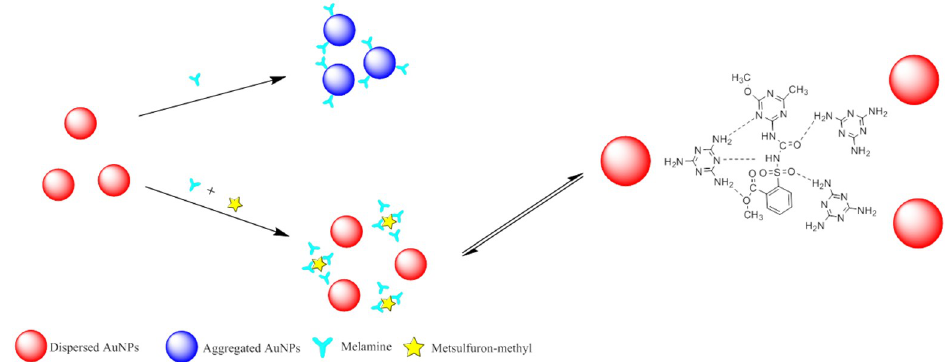
Figure 6. Sensing principle for metsulfuron-methyl analysis based on anti-aggregation of gold nanoparticles. Reproduced with permission from reference [120].